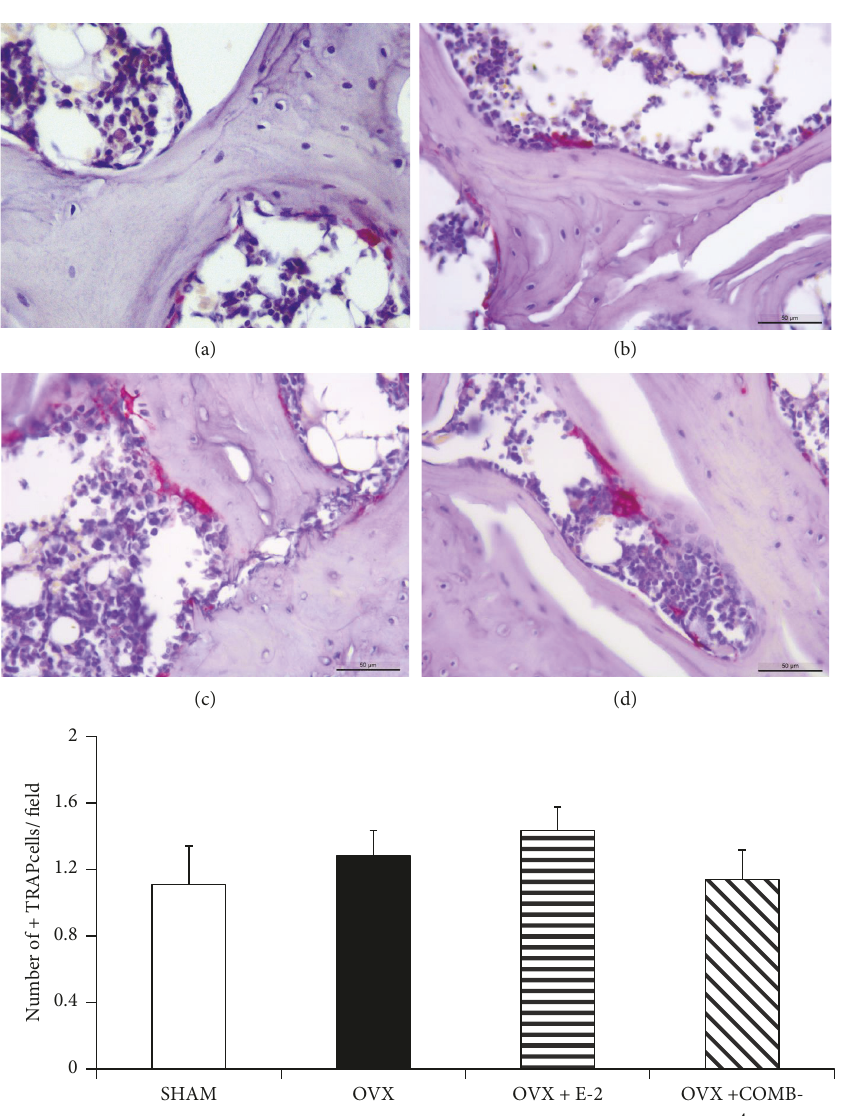
Figure 7: Tartrate acid phosphatase (TRAP) staining in femur. Paraffin embedded sections of proximal epiphysis of the femora were stained with prewarmed TRAP staining solution, as in Figure 6. Top Panel: representative images of positive trap cells in (a): SHAM, (b): OVX, (c): OVX+E2, and (d): OVX+COMB-4 after 100 days of treatment. TRAP+ cells are stained in pink/violet. Sections were counterstained with hematoxylin to observe the cell nuclei. Magnification 400X; Bar: 50 um. Bottom Panel: number of TRAP-positive staining cells per field. No significant difference was observed among the groups. n = 8 per